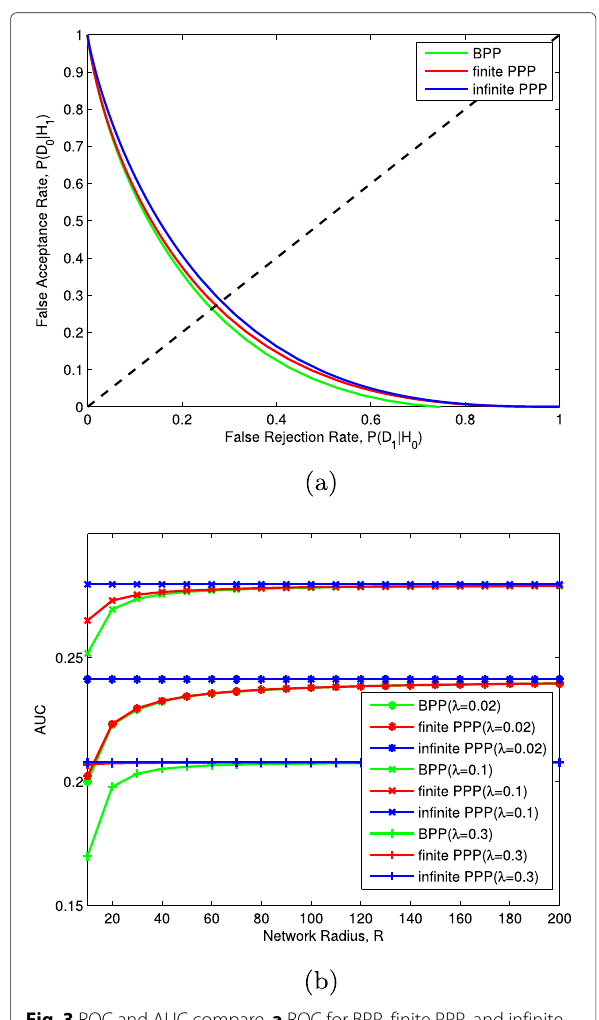
Fig. 3 ROC and AUC compare. a ROC for BPP, finite PPP, and infinite PPP. b AUC for BPP, finite PPP, and infinite